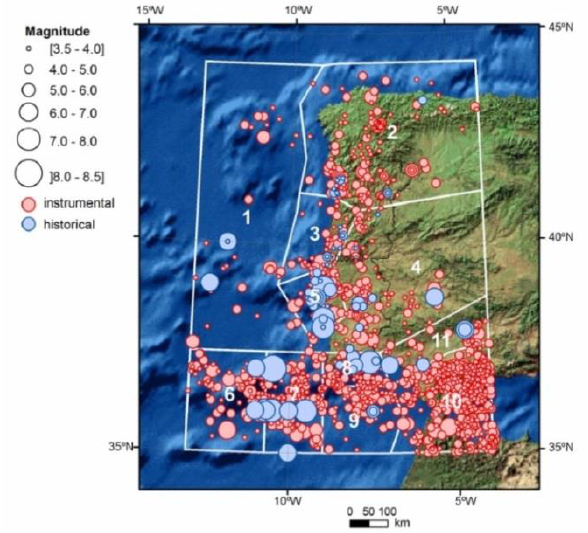
Figure 1. Seismic zonation map used to support EC8 code zoning for Portugal (IPQ, 2010) (adapted from Campos Costa et al.